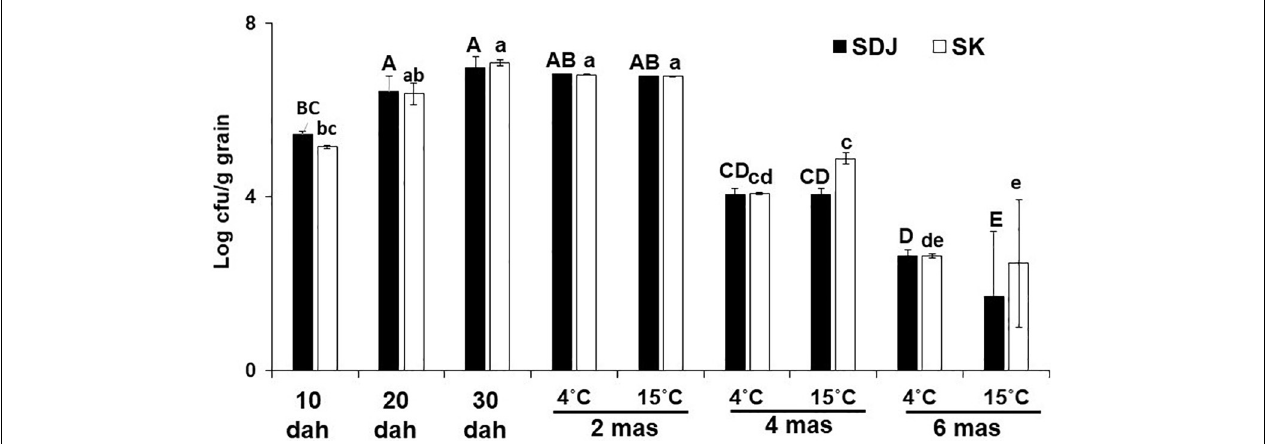
FIGURE 2 | Total culturable bacterial populations in rice seeds during ripening and storage stages. Rice seeds of varieties Shindongjin (SDJ) and Sukwang (SK) were collected during the ripening stage, 10 days after heading (dah), 20 dah, and 30 dah; during storage, 2 months after storage (mas), 4 mas, and 6 mas from harvesting. Culturable bacteria were estimated in 1/10 TSA media amended with 1% RSE. Data represent mean ± SD and bars with the same letter do not differ significantly at P = 0.05 for each